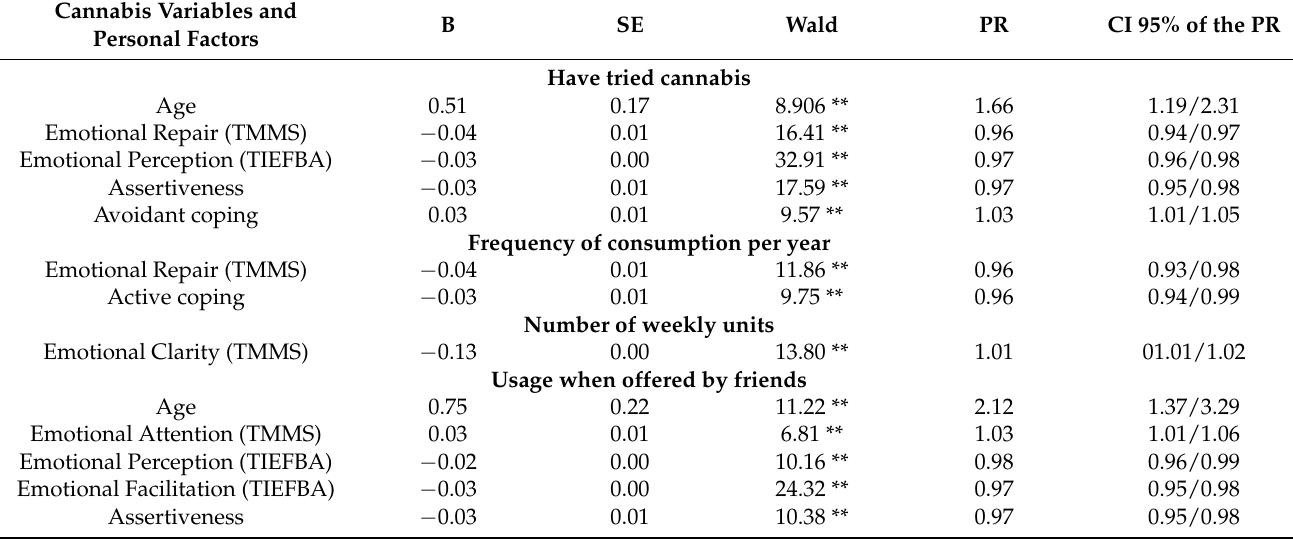
Table 3. Binomial regression analysis of personal protective factors controlled by age and gender regarding cannabis use.